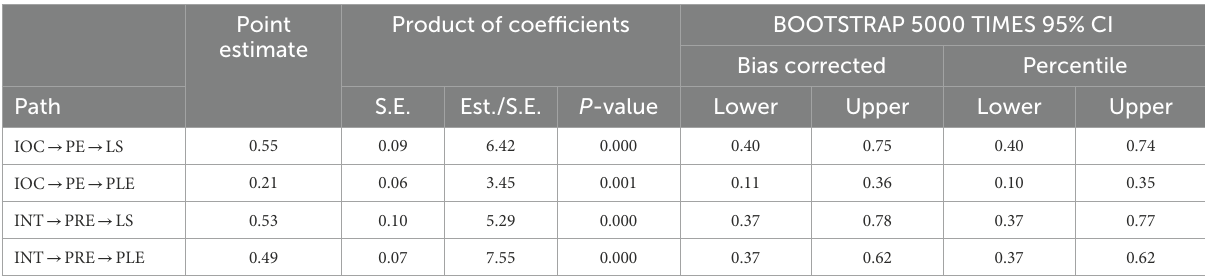
TABLE 3 Standardized bootstrap mediation